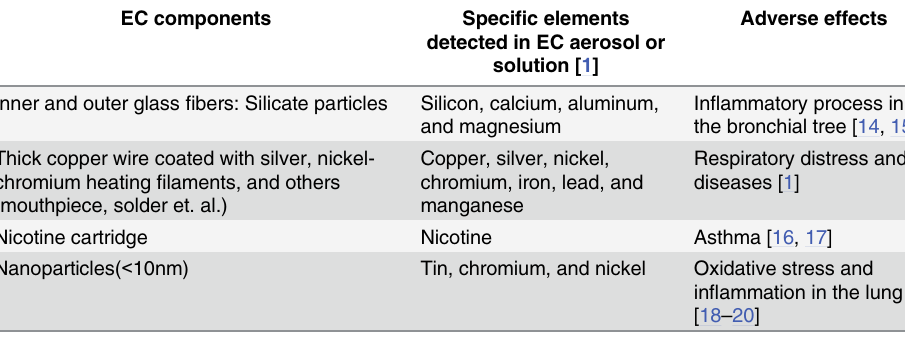
Table 1. Summery for EC components and adverse effects. EC components